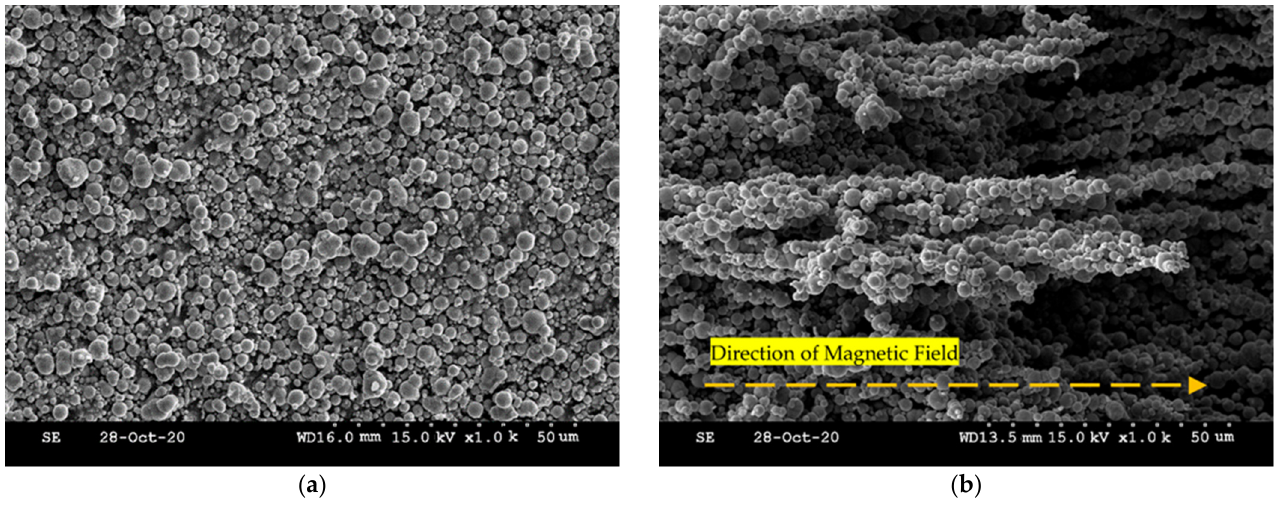
Figure 4. The micro-behavior of particle motion in MRF: ( a ) off a magnetic field, ( b ) on a magnetic field .